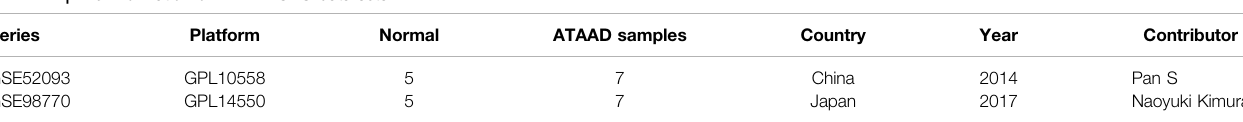
TABLE 1 | The information of ATAAD GEO data